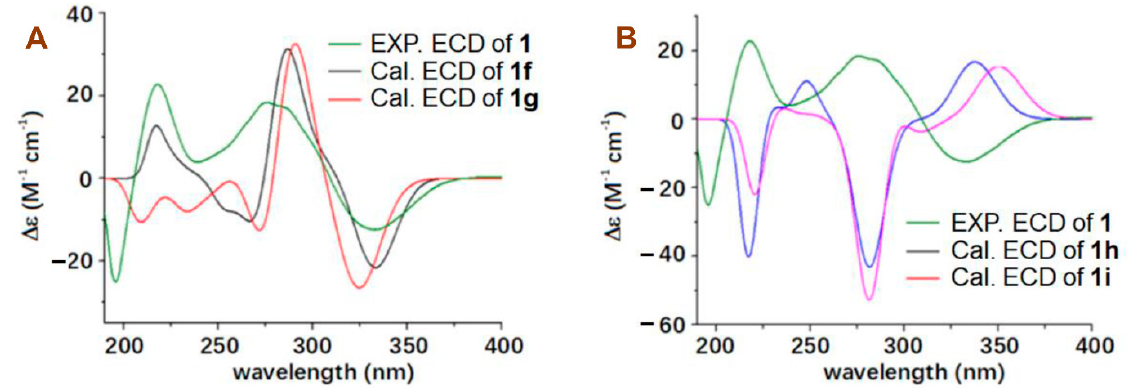
Figure 4. The experimental ECD spectrum of penipyridinone B ( 1 ) in MeOH and the calculated ECD curves of four model molecules 1f, 1g ( A ) , 1h and 1i ( B ) at the b3lyp/6-311+g (d, p) level in